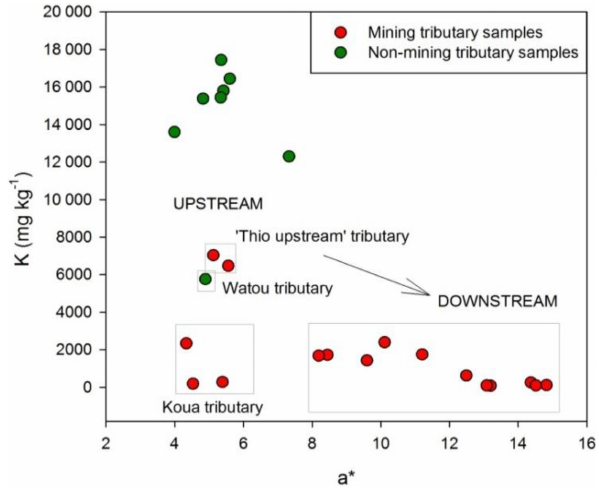
Figure 13. Diagram of K contents as a function of a ∗ parameter values within sediment sources and artificial mixture